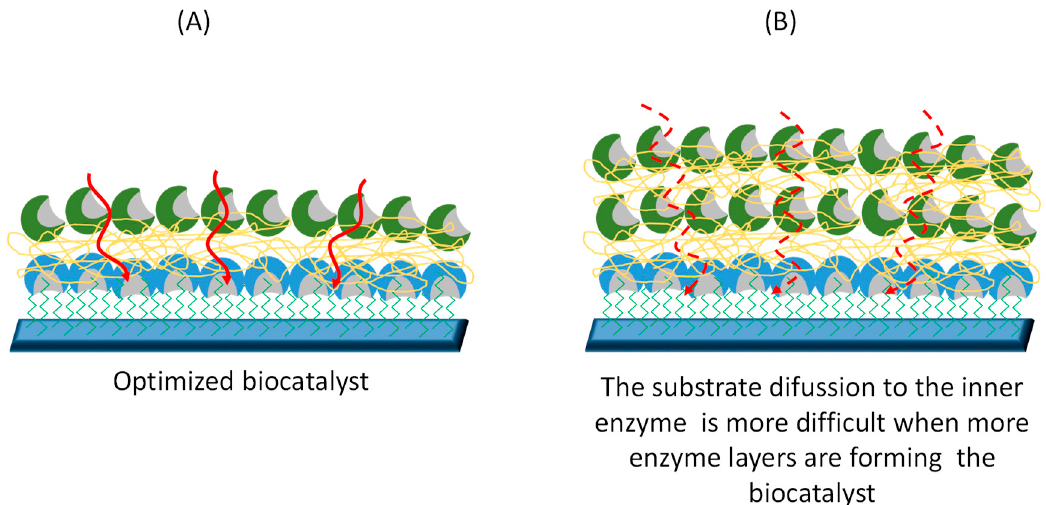
Figure 9. Increased tortuosity results in a different lifetime for the substrate to the enzyme immobi- lized on the support surface when using a multi-layer biocatalyst. ( A ) In a biocatalyst with one or two layer or enzyme the substrate diffuses with relative ease through the layers. ( B ) When more layers are added the substrate may experiment diffusional problems when reaching the deepest layers.